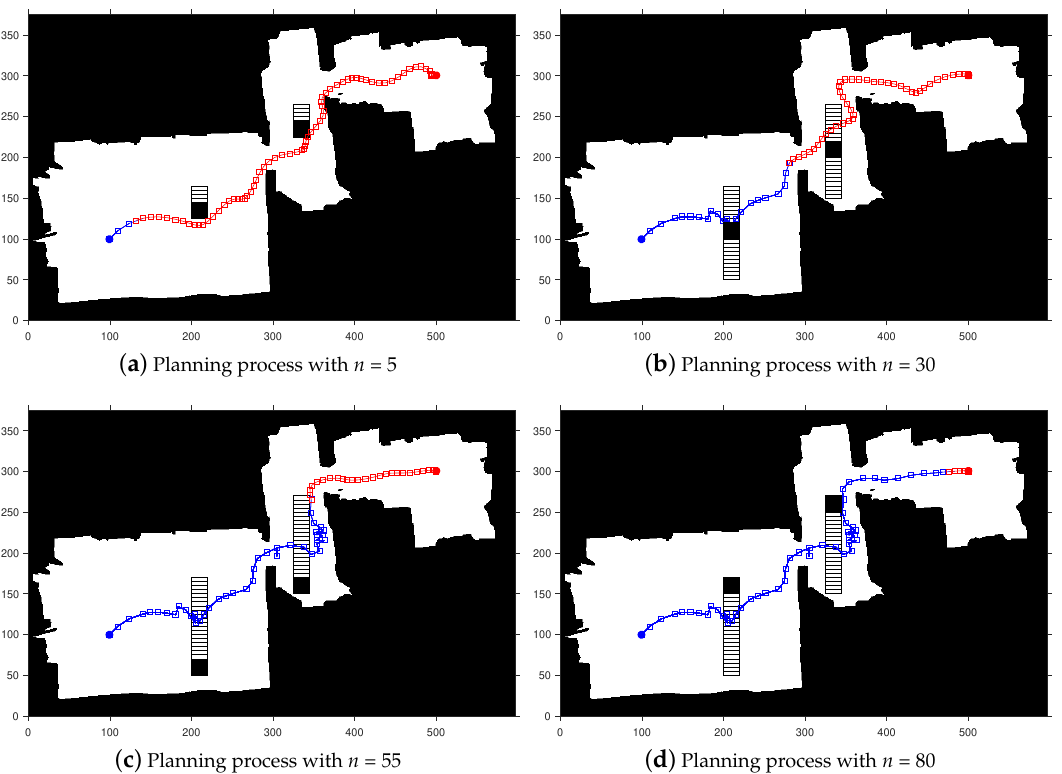
Figure 7. The process of exploring a path on a map with vertical dynamic obstacles.